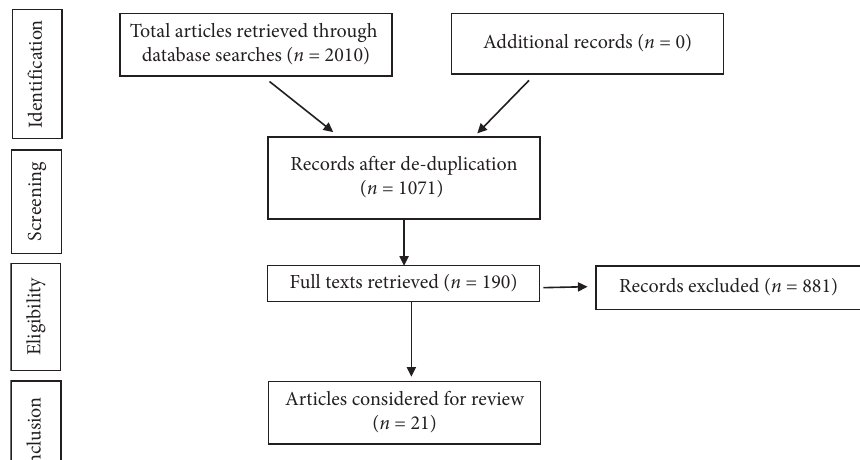
Figure 1: PRISMA flowchart of